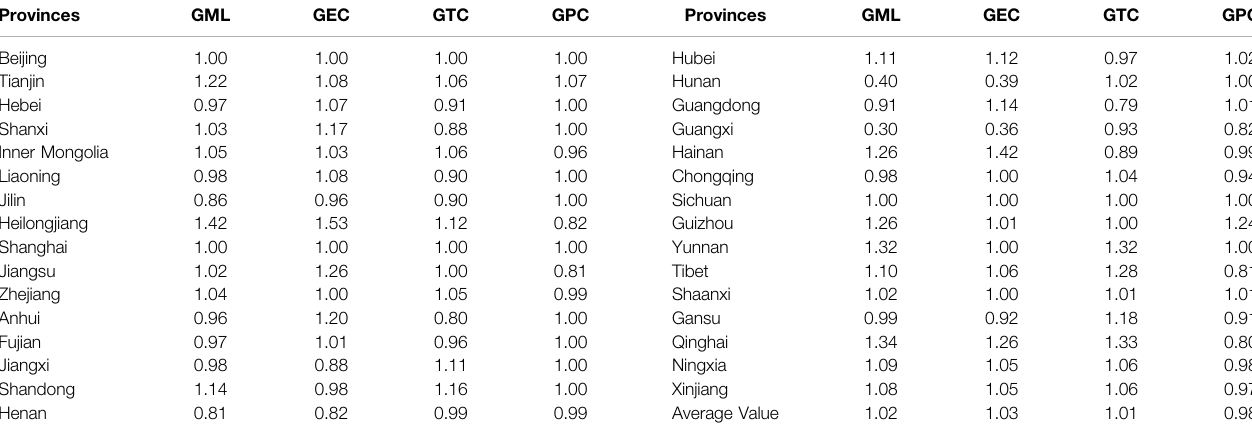
TABLE 2 | GML index and its factorization of China ’ s green agriculture development in 2019. Provinces GML GEC GTC GPC